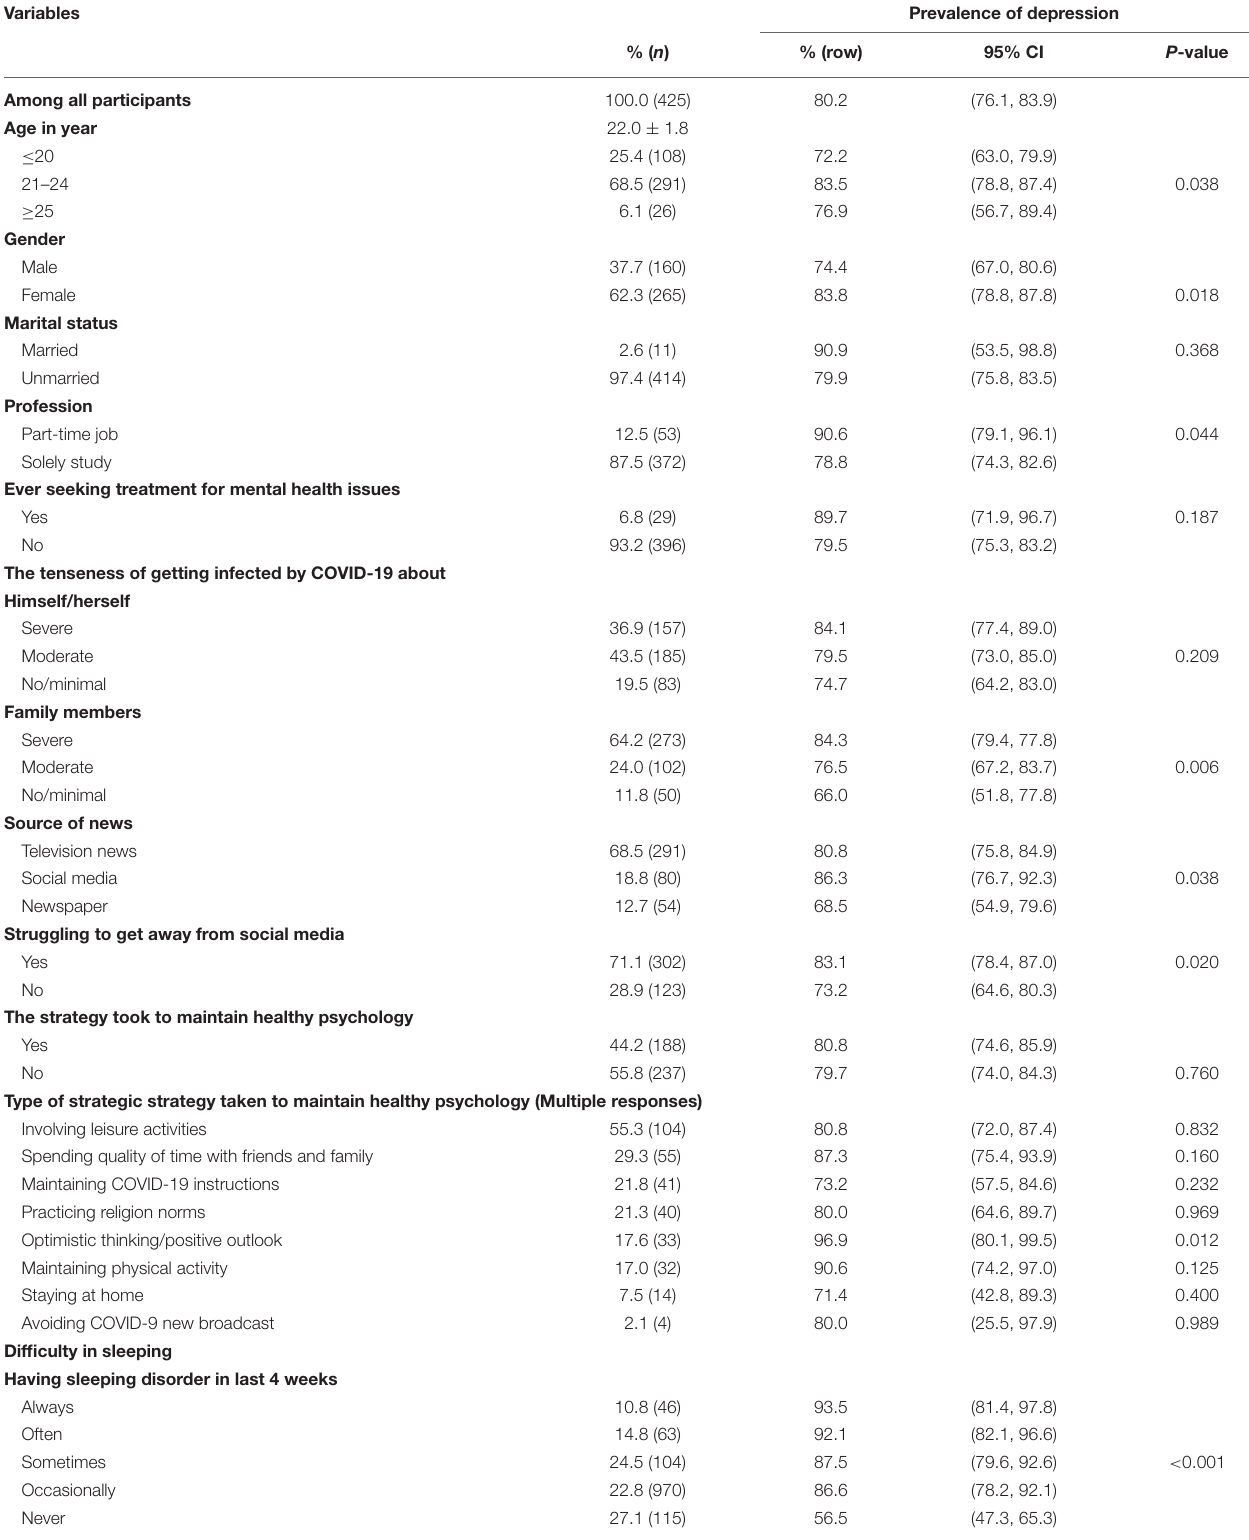
TABLE 1 | Prevalence of mild to severe depressive symptom among medical students, measured by PHQ-9, during COVID-19 pandemic following their demographic and pandemic related characteristics, 2020